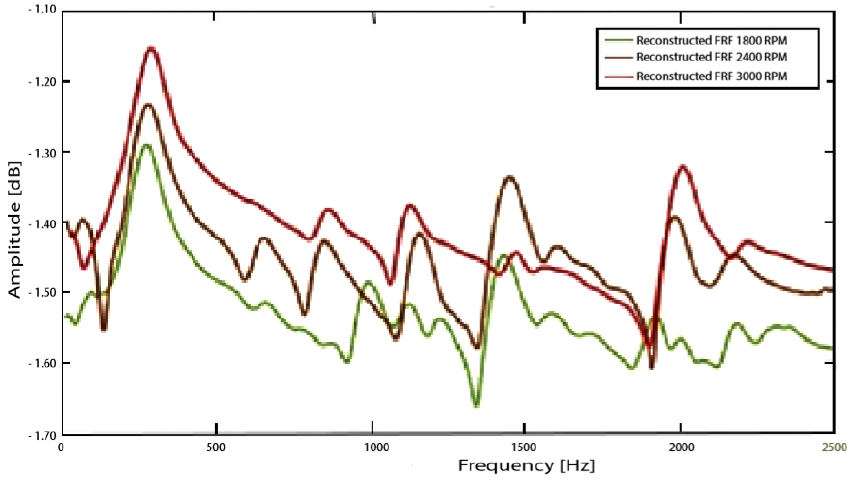
Figure 9. Comparison of the induction motor’s regenerated FRFs, with varying speeds (1800, 2400 and 3000 rpm).